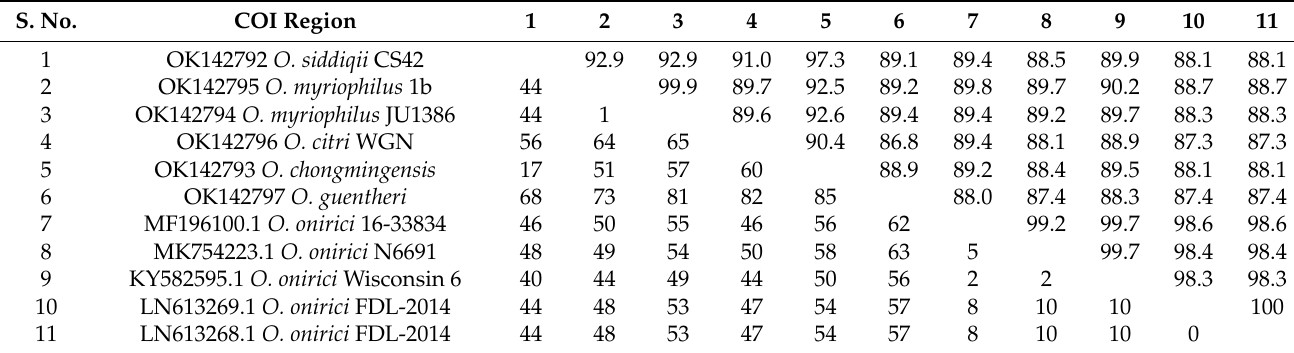
Table 3. Pairwise distances of the COI gene among selected Oscheius species. The values above diagonal represent percent similarities, and the values below diagonal represent numbers of character differences. S.